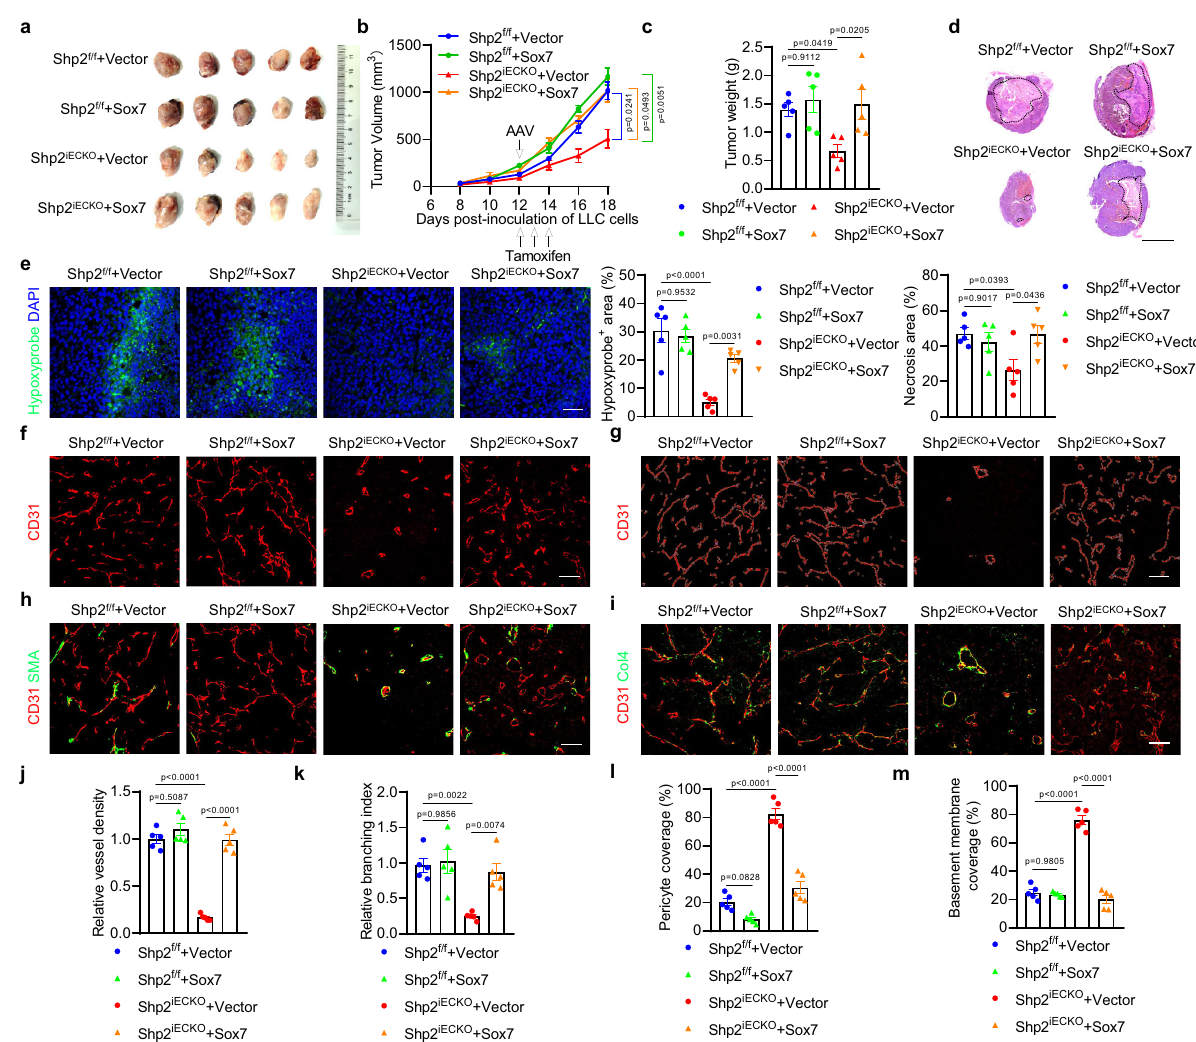
Fig. 5 SOX7 is required for SHP2 to promote tumor angiogenesis and vessel abnormalization. a Images of LLC tumors from Shp2 f/f ( n = 5) and Shp2 iECKO ( n = 5) mice treated with AAV-Sox7. b , c Tumor volumes ( b ) and tumor weights ( c ) of LLC tumors from Shp2 f/f ( n = 5) and Shp2 iECKO ( n = 5) mice treated with AAV-Sox7. Arrows indicated the time points for AAV and tamoxifen injection. Tumor weights were measured 18 days after cancer cell injection. Quantitative data were shown as mean ± SEM. p -values were shown and generated by two-way ANOVA with Tukey ’ s post hoc test ( b ) or one- way ANOVA with multi-comparisons ( c ). d Representative images of LLC tumor necrosis. Necrosis areas were labeled by dot lines. Images were analyzed by the Image J software and quantitative data were shown as mean ± SEM. n = 5 in each group. p -values were shown and generated by one-way ANOVA with multi-comparisons. Scale bar: 10 mm. e Representative images of hypoxyprobe-1 labeled areas in LLC tumors. Images were analyzed by the Image J software and quantitative data were shown as mean ± SEM. n = 5 in each group. p -values were shown and generated by one-way ANOVA with multi- comparisons. Scale bar: 100 μ m. f – m Immuno fl uorescence images of CD31 ( f , g ), α SMA (h), and collagen IV ( i , Col4) in LLC tumors. Vessel density ( j ), branching index ( k ), pericyte coverage ( l ), basement membrane coverage ( m ) were measured by using the Image J software and quantitative data were shown as mean ± SEM. n = 5 in each groups. p -values were shown and generated by one-way ANOVA with multi-comparisons. Scale bar: 100 μ m. Source data are provided as a Source data fi